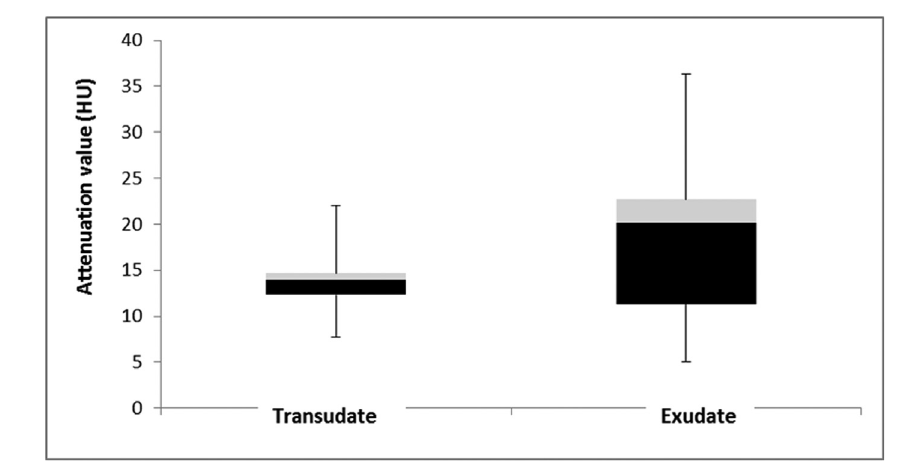
Box plots showing the attenuation values for transudative and exudative effusion. The boxes stretch from the 1st quartile to the 3rd quartiles. The junction between each two boxes is the mean. The vertical lines with whiskers extending below and above the boxes indicate the minimum and maximum values, respectively. HU,